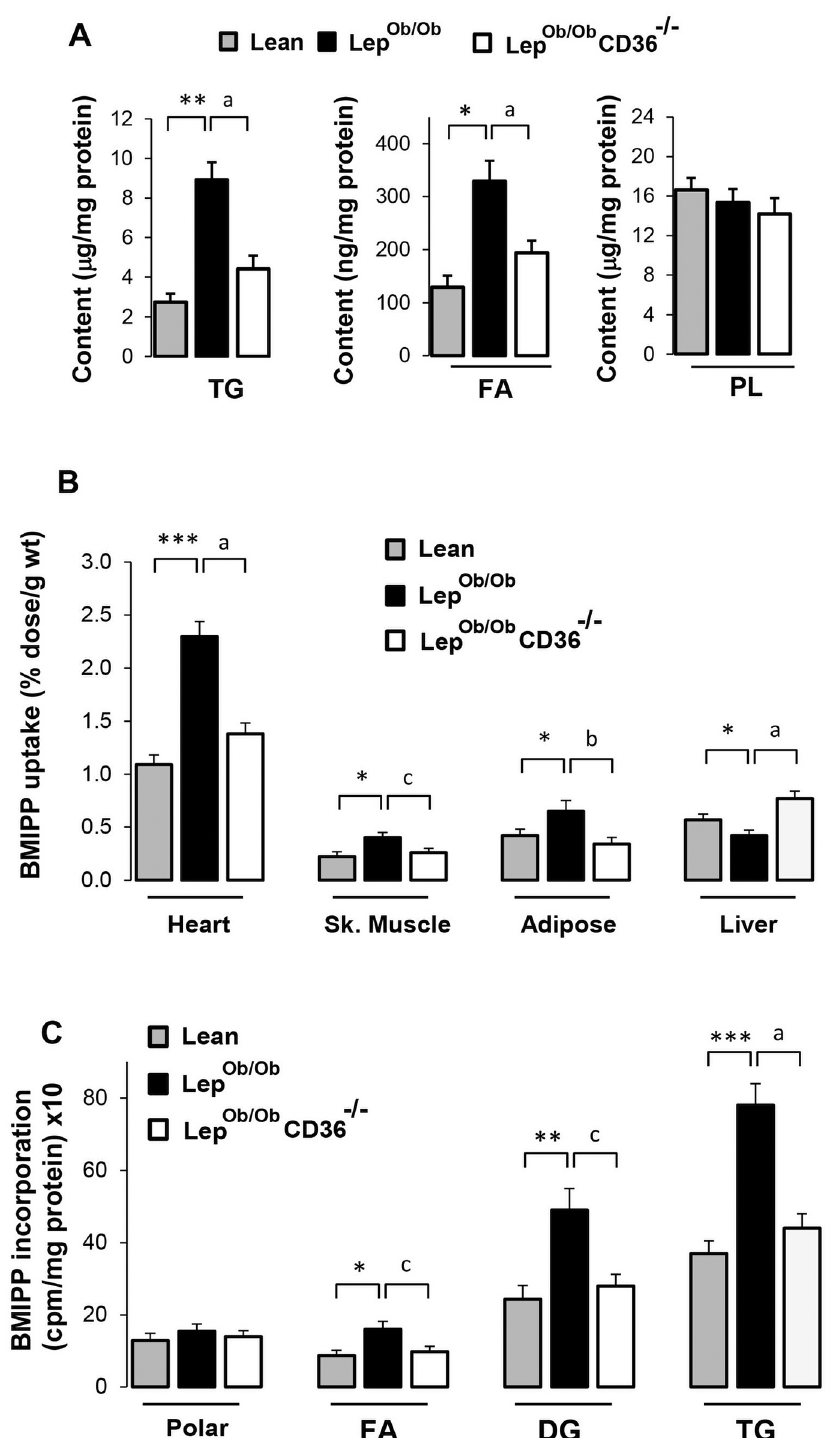
Fig 3. Effects of CD36 deficiency on cardiac lipid contents, fatty uptake and incorporation in lipids. Cardiac lipid contents (A) were determined enzymatically after lipid extraction as described in the Methods. Fatty acid uptake in indicated organs (B) was assessed using 125 I-BMIPP. Mice were injected with 5 μ Ci of 125 I-BMIPP into the tail vein and tissues were removed 2 h later. Incorporation of BMIPP in heart lipids (C) was examined after extraction and TLC separation. Polar lipids include phospholipids